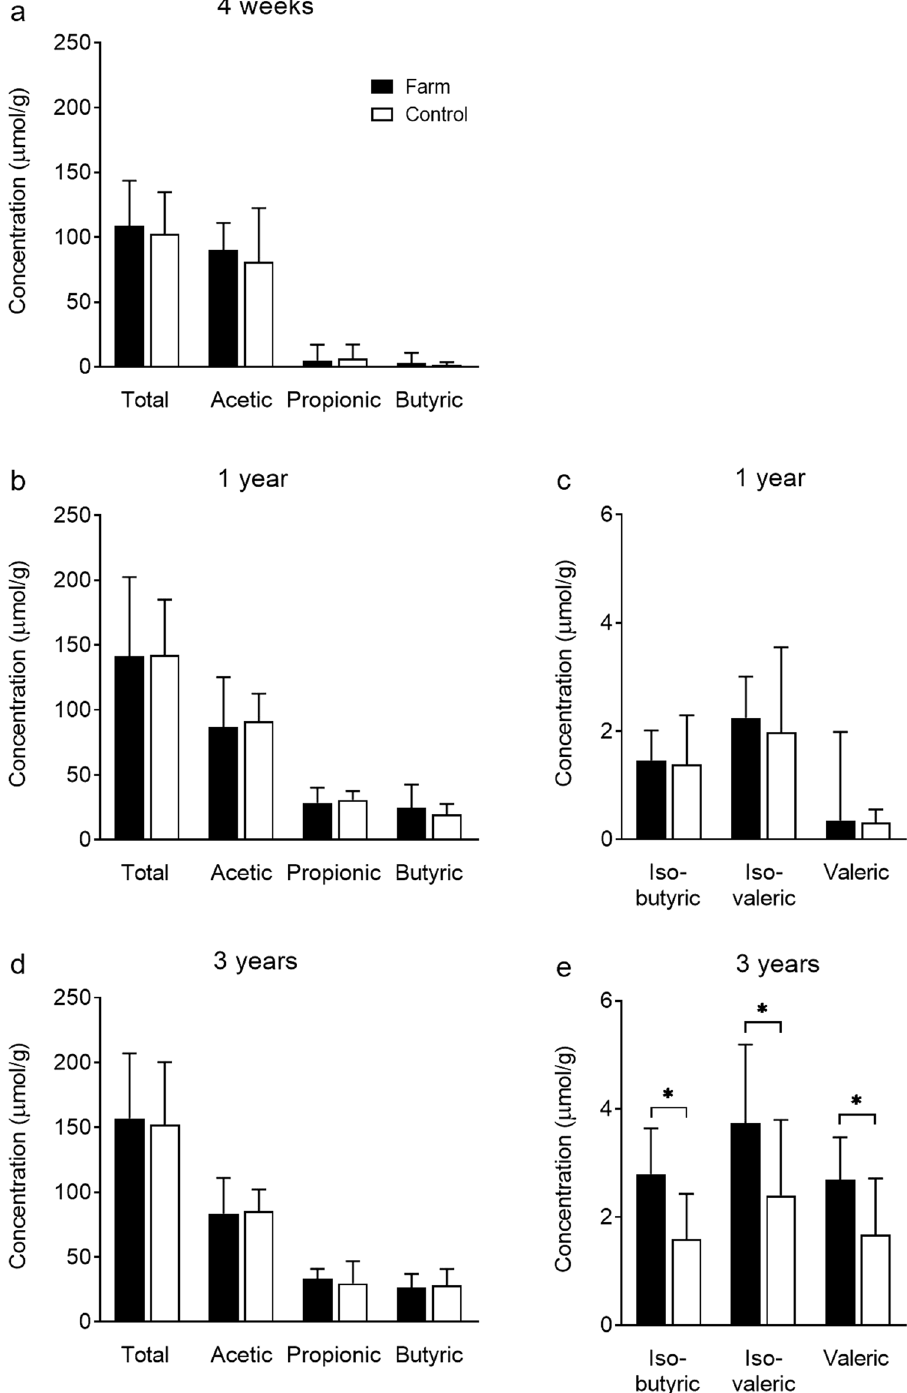
Figure 2. Fecal SCFA levels in farm and control children. Median concentration of total SCFAs and individual species of SCFAs in farm and rural control children at ( a ) 4 weeks, n = 24 (farm) and 23 (control); ( b , c ) 1 year, n = 28 (farm) and 36 (control), and ( d , e ) 3 years of age, n = 19 (farm) and 32 (control). Error bars show the interquartile range. * P < 0.05, Mann–Whitney